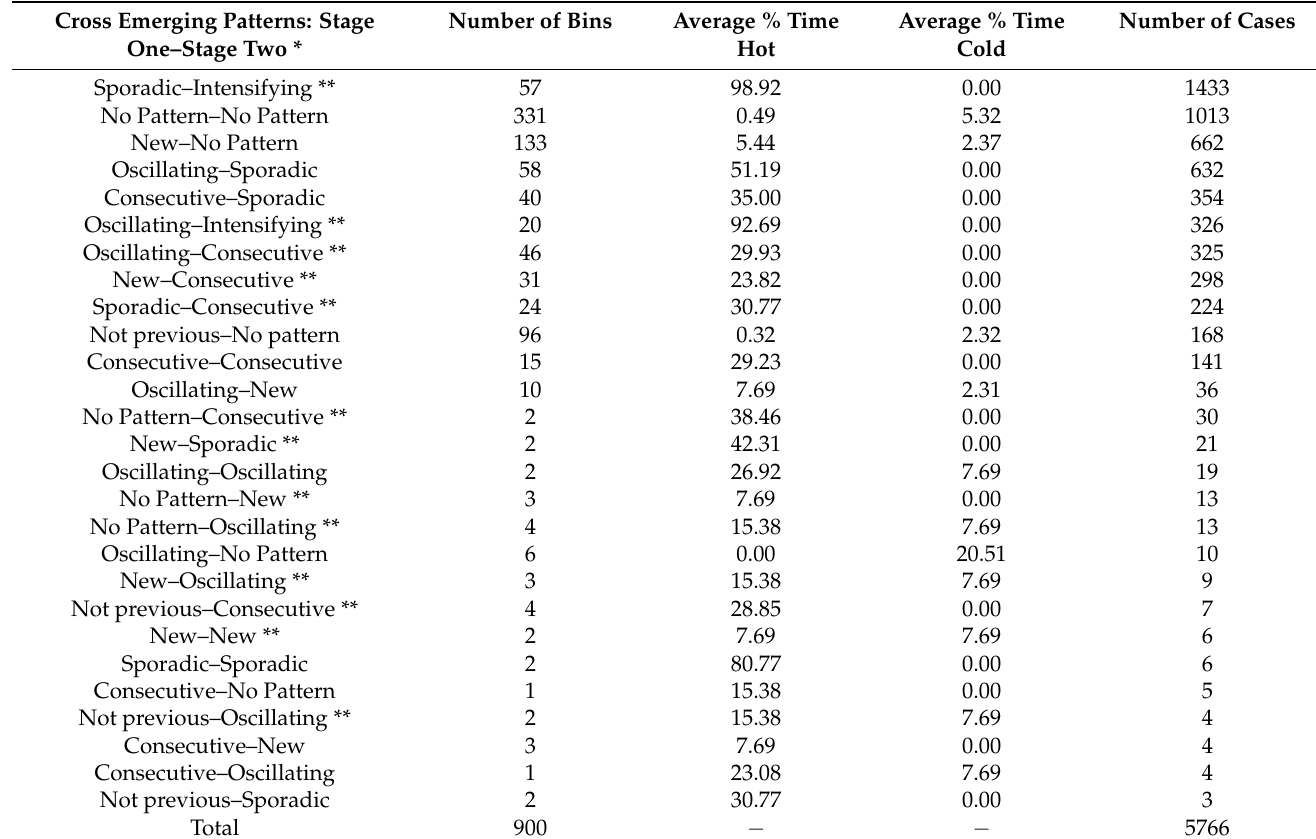
Table 5. Cross-analysis of types of emerging hotspots (stage 1–stage 2), in decreasing order of number of COVID-19 cases. Cross Emerging Patterns: